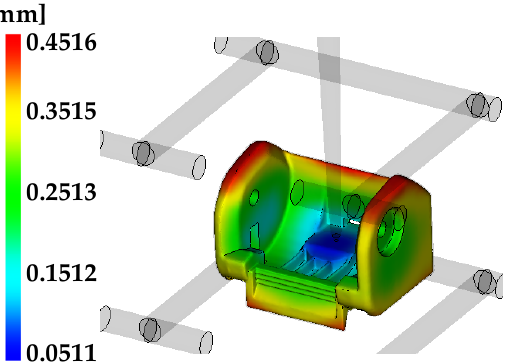
Figure 12. Deflection for pivot sub-assembly after applying 0.2% shrinkage constant. Table 21. Results of dimension 1, 2, 3 for pivot sub-assembly with 0.2% shrinkage constant ap- plied.